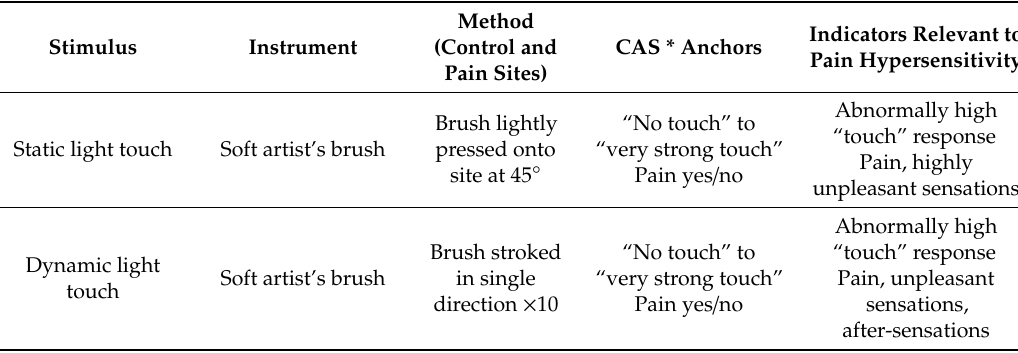
Table 2. Summary of somatosensory testing